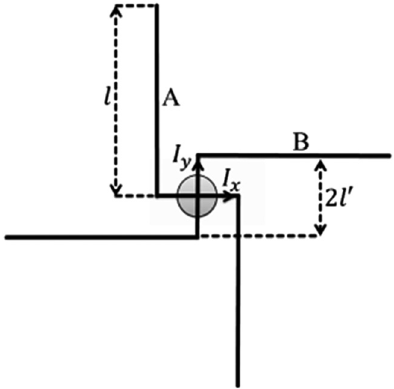
Figure 8: Moving Chiral nonreciprocal magnetoelectric particle (reprinted with permission from Ref.